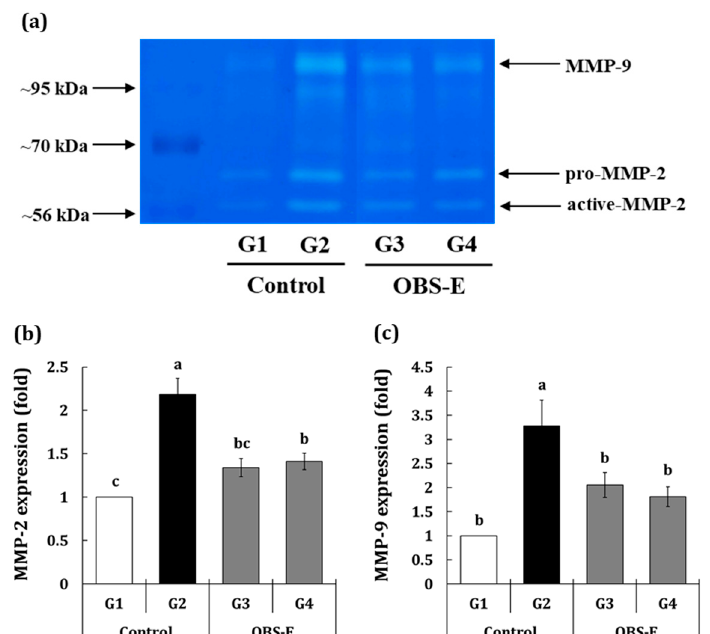
Figure 2. Effect of oral administration of OBS-E on wrinkle formation. ( a ) total wrinkle area, ( b ) wrinkle number, ( c ) wrinkle length, and ( d ) wrinkle depth. G1, non-irradiated control group ad- ministered saline; G2, UVB-irradiated control group administered saline; G3 and G4, UVB-irradi- ated test agent groups administered OBS-E at doses of 50 and 200 mg/kg BW/day, respectively. Different superscripts indicate significant difference among groups by Duncan’s multiple range test ( p < 0.05).